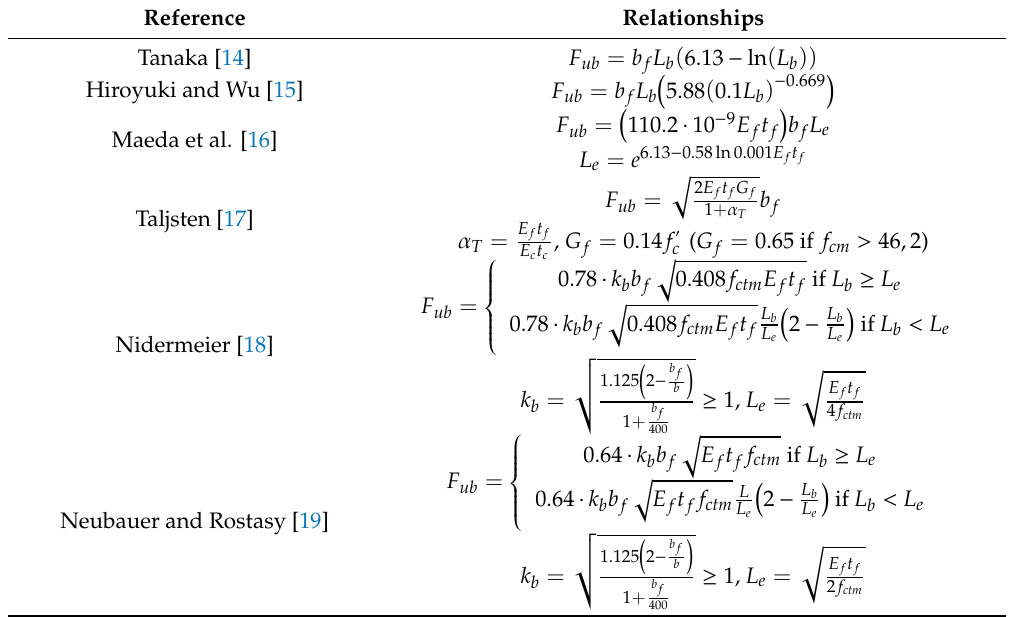
Table 1. Predictive models for the FRP-concrete